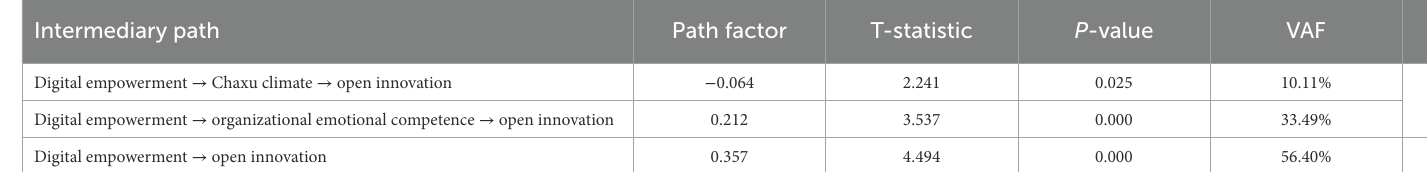
TABLE 7 Mediated effects completeness